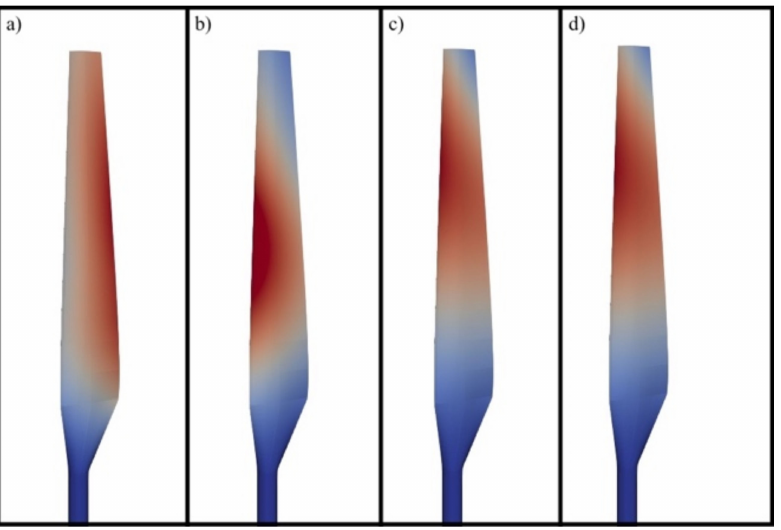
Figure 9. Pressure distribution over simulation time: ( a ) 0.1 s, ( b ) 0.5 s, ( c ) 1 s, ( d ) 1.5 s. (Wind velocity 7 m/s and blade rotational velocity 72